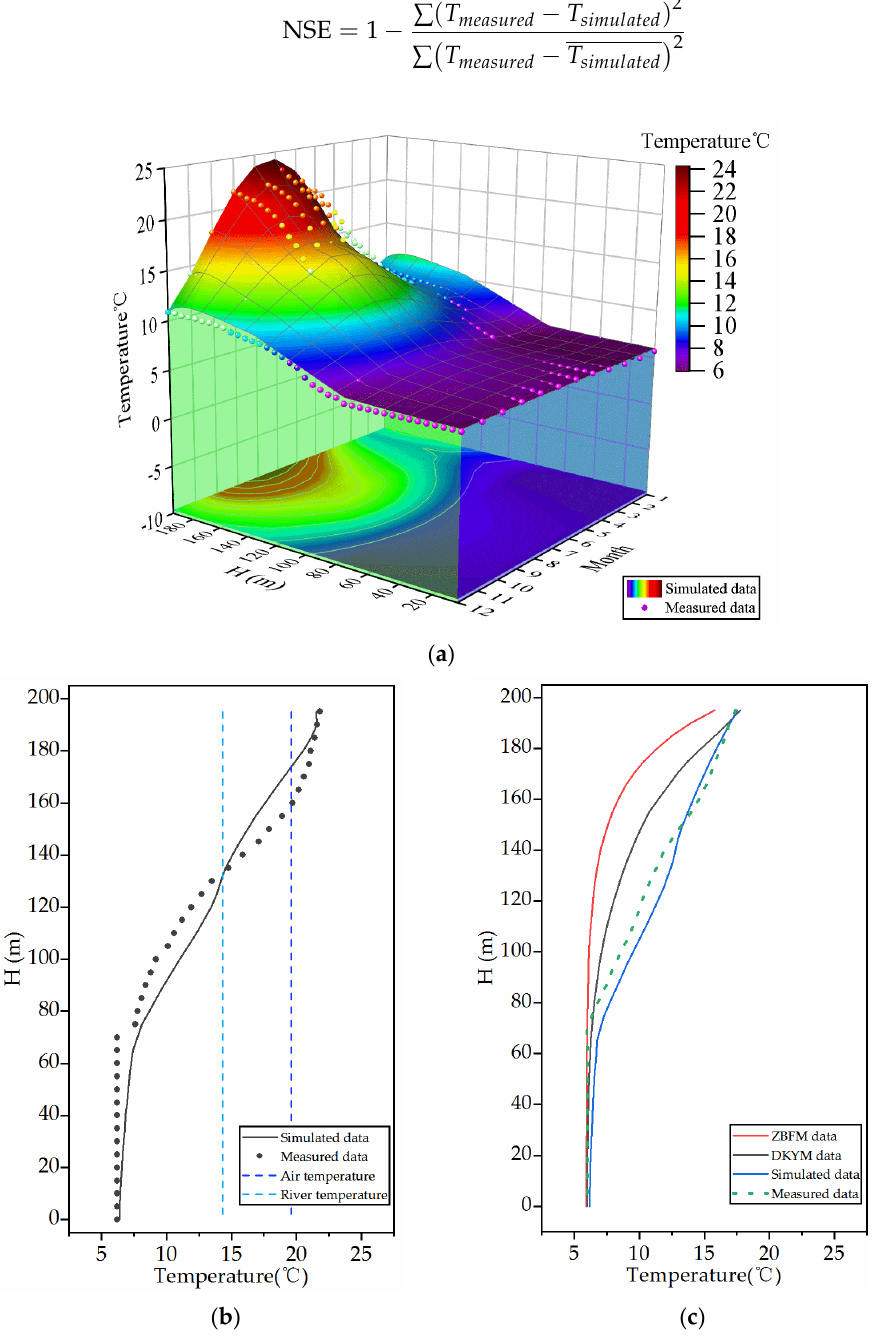
Figure 5. Comparison between simulation data and measured data. ( a ) Comparison between simulation data and measured data. ( b ) September. ( c ) Average temperature. Table 3. Analysis of error for the whole year ( ◦